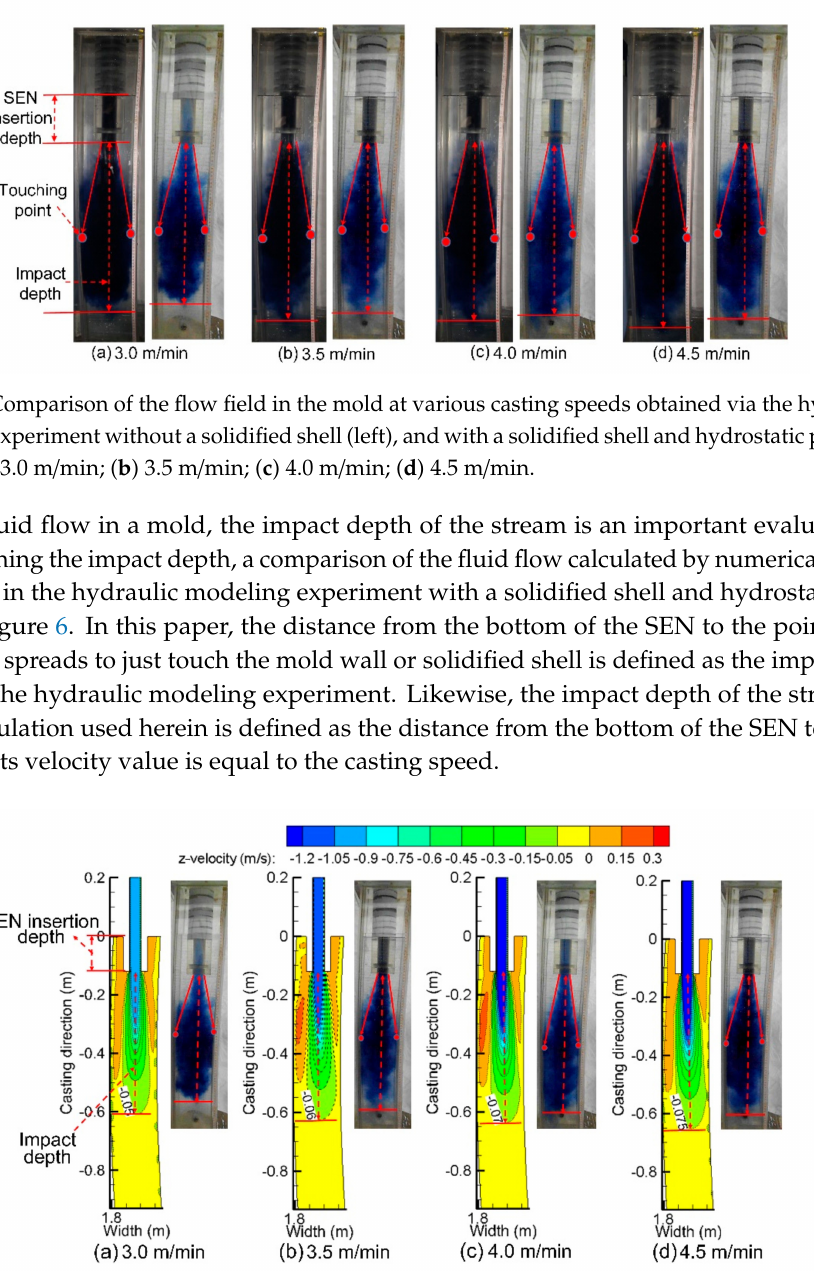
Figure 6. Comparison of the fluid flow in the mold at various casting speeds obtained via numerical simulation, and hydraulic modeling experiment with a solidified shell and hydrostatic pressure. ( a ) 3.0 m / min; ( b ) 3.5 m / min; ( c ) 4.0 m / min; ( d ) 4.5 m /